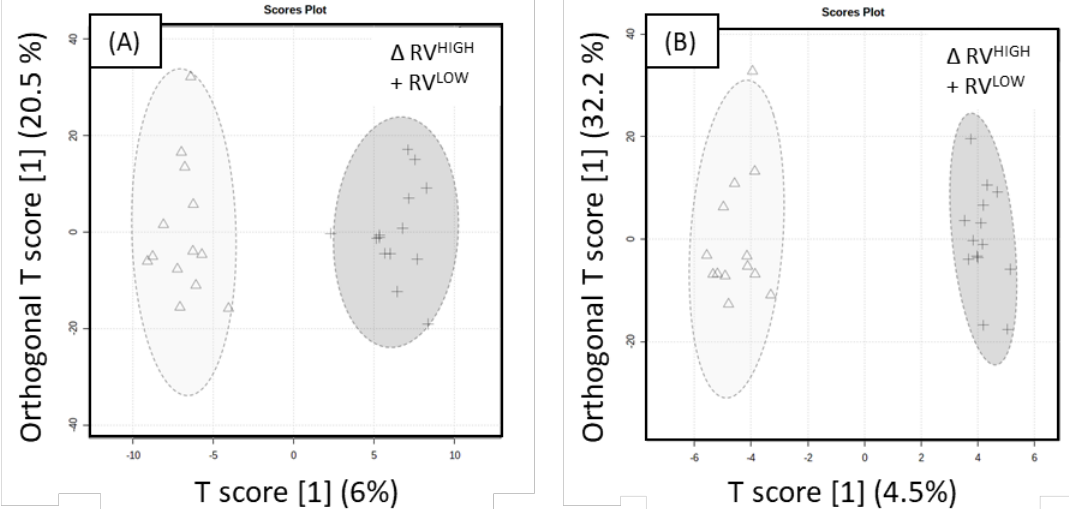
Figure 4. Orthogonal partial least squares discriminant analysis (OPLS-DA) of RV LOW and RV HIGH extracts acquired in UHPLC-HRMS. RV LOW (+) and RV HIGH ( ∆ ) OPLS-DA score plot of ( A ) ESI+ mode with an associated 95% confidence ellipses (Q 2 = 0.231, R 2 Y = 0.647) and ( B ) ESI- mode with an associated 95% confidence ellipses (Q 2 = 0.071, R 2 Y = 0.593). Both models were significant indicated by 100 different model permutations for ( A ) ( p < 0.01, Q 2 = 0.757 and R 2 Y = 0.985) and ( B ) ( p < 0.01, Q 2 = 0.785 and R 2 Y = 0.983).